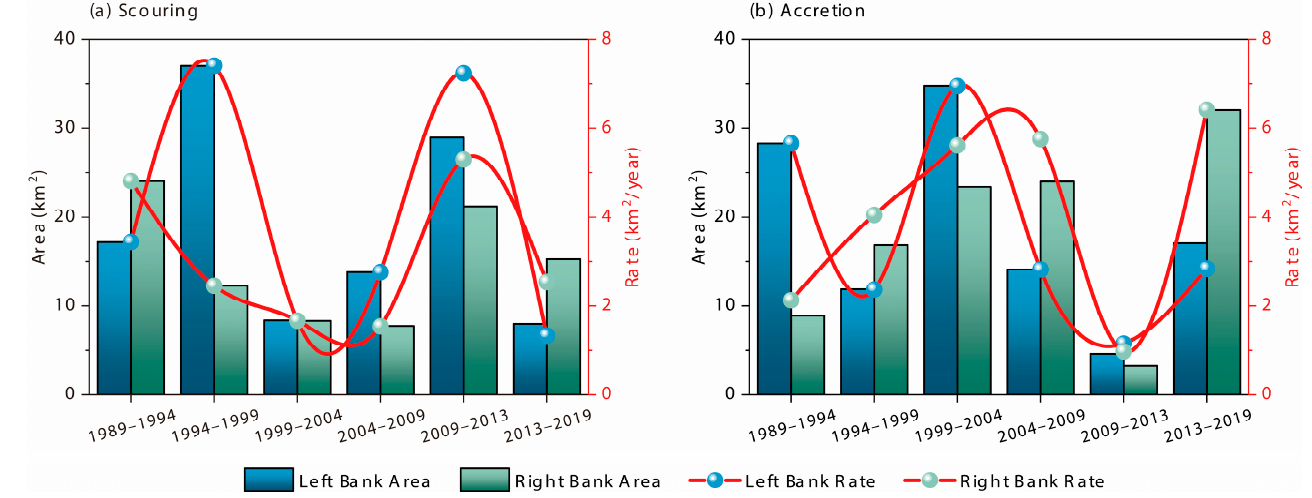
Figure 12. Scouring and accretion on the left and right banks, 1989–2019. ( a ): Scouring; ( b ): Accre-